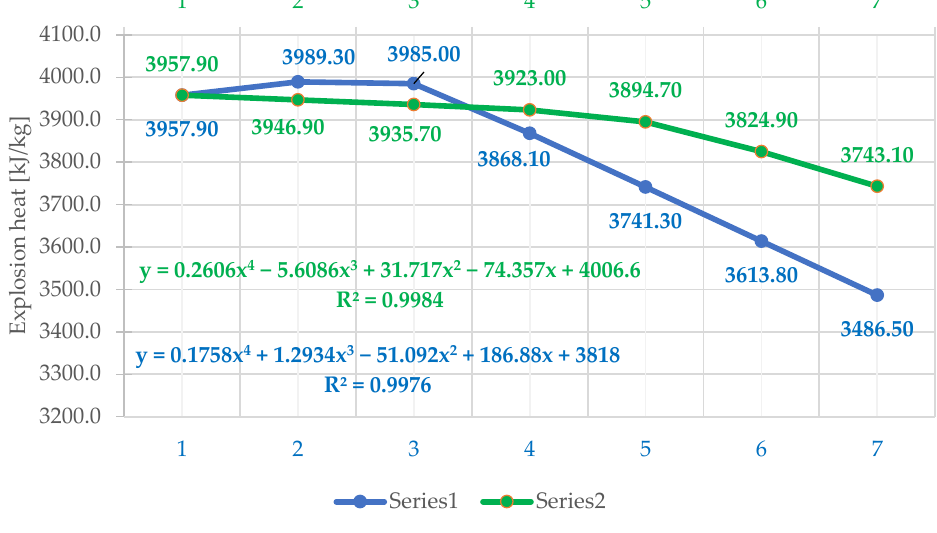
Figure 2. Changes in the explosion heat for individual explosives.